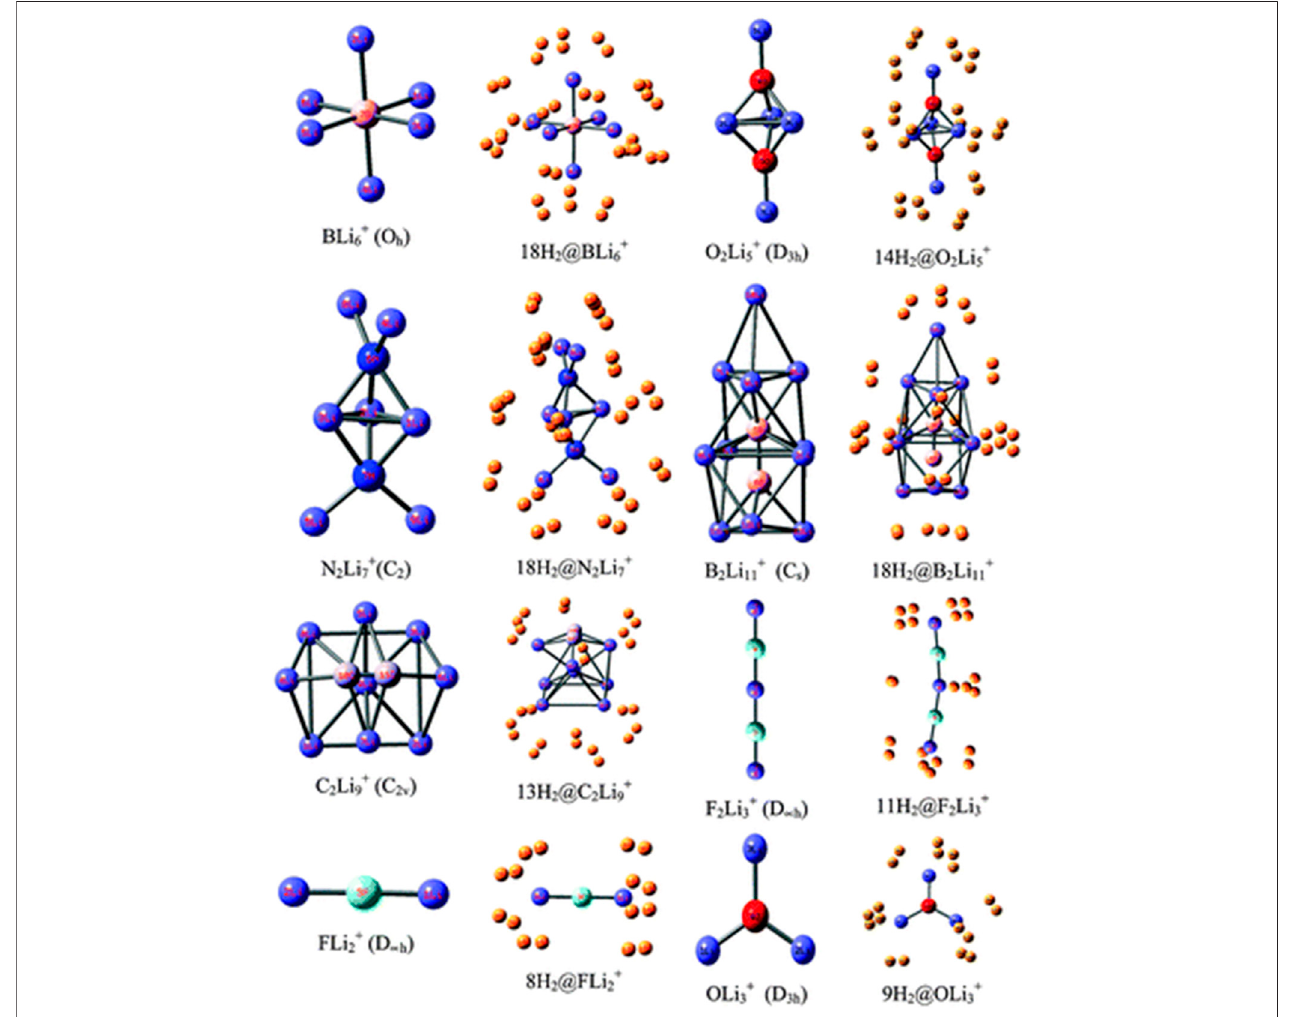
FIGURE 14 | Optimized structures of studied super-alkali ions and their hydrogen-trapped analogues at the M052X/6-311+G(d) level. (Adapted from Pan et al., 2012b with permission from the PCCP Owner Societies.).